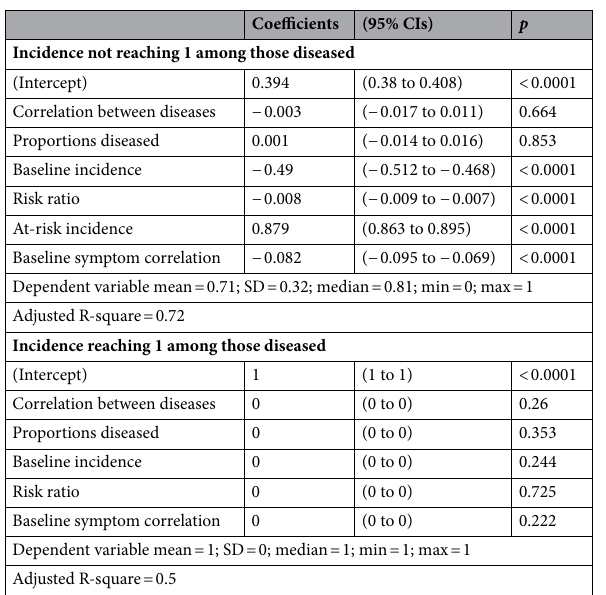
Table 9. Effects of baseline incidence, proportions diseased, risk ratios, and baseline symptom correlations on the sensitivities obtained from the maximal area under the receiver operating characteristic curve using at most 40 symptoms for disease diagnosis. CI confidence interval, SD standard deviation.